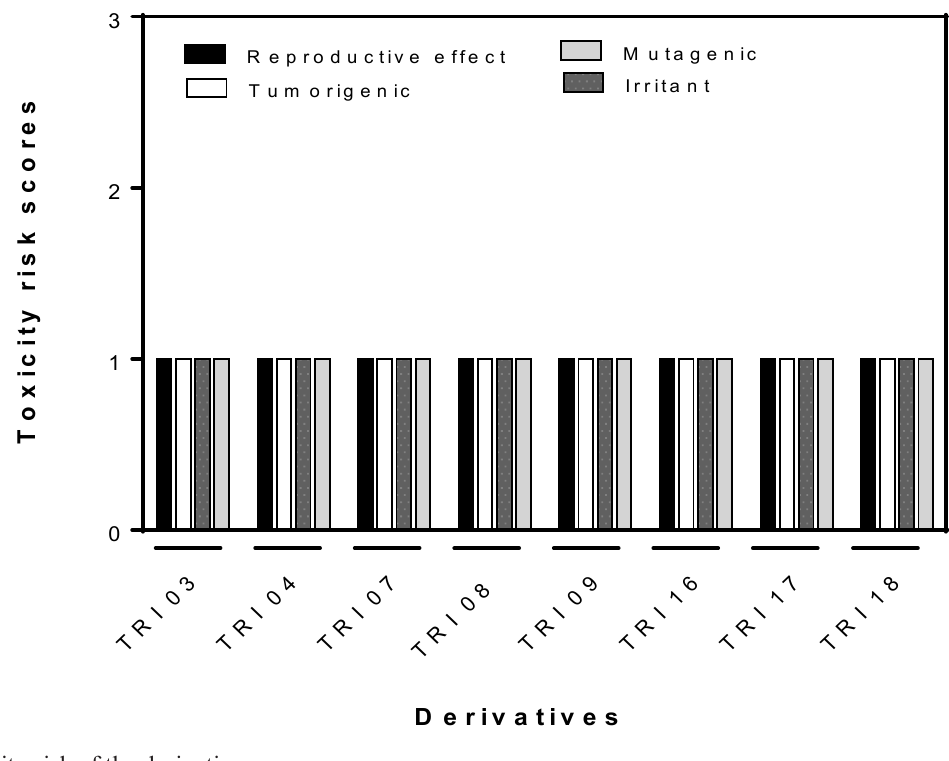
FIGURE 5 - Toxicity risk of the derivatives The derivatives (TRI 03, TRI 04, TRI 07, TRI 08, TRI 09, TRI 16, TRI 17, and TRI 18) were evaluated on their theoretical risk of toxicity, negative reproductive effect, tumorigenic, mutagenic, and irritant aspects using the software Osiris Property Explorer ® . Toxicity risk scores are: 1 = low toxicity , 2 = moderate toxicity, 3 = high